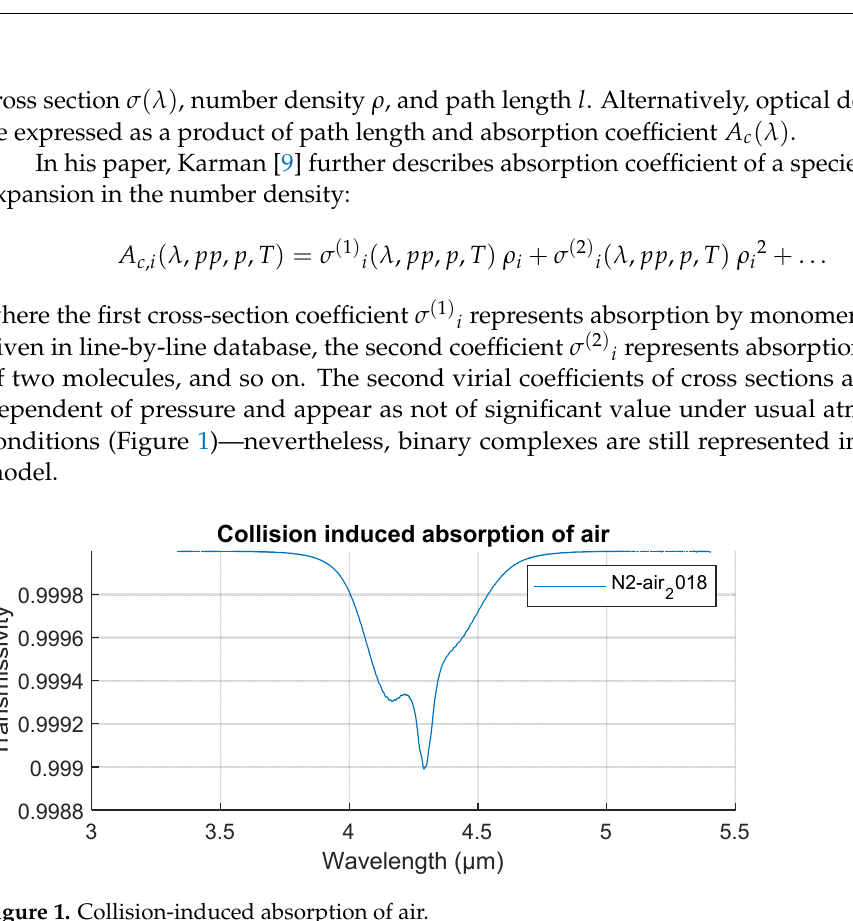
species and path length l . Note that constant gas species number densities were used upon ρ i / ρ i _ ref is used afterwards—one for dry gases with presumably constant composition, and one for water